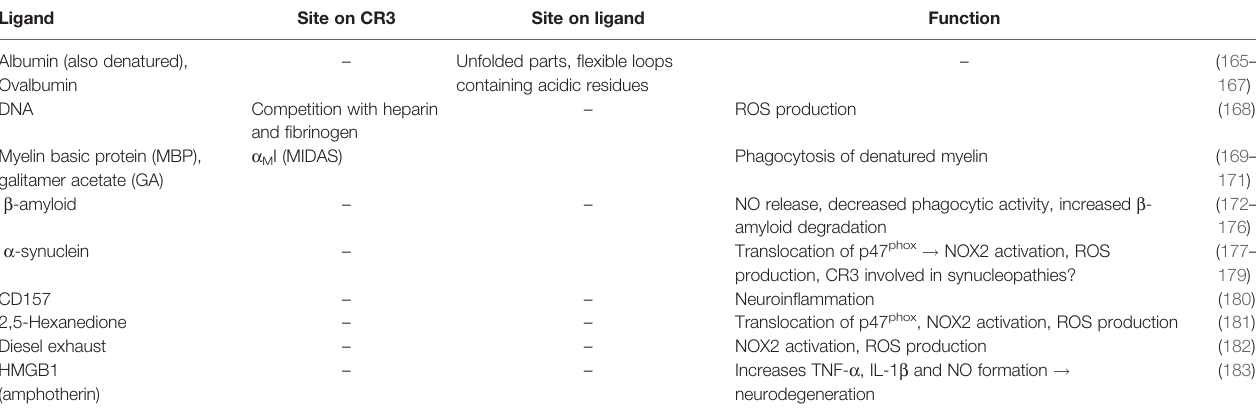
TABLE 4 | Recognition of host damage